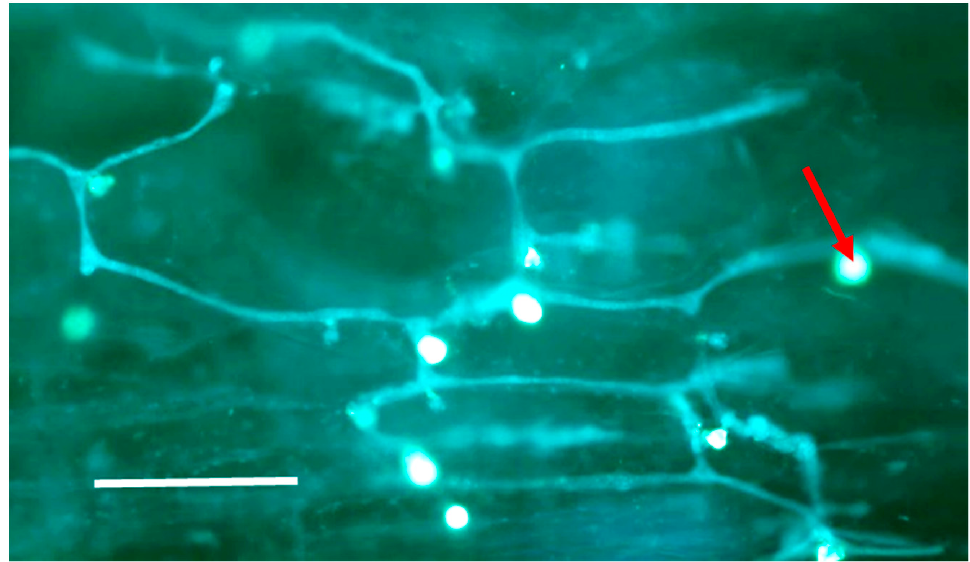
Figure 2. A photomicrograph showing mycelium with haustoria (arrow) of P. belbahrii inside the stem of a systemically infected basil plant. Bar = 50 µm.